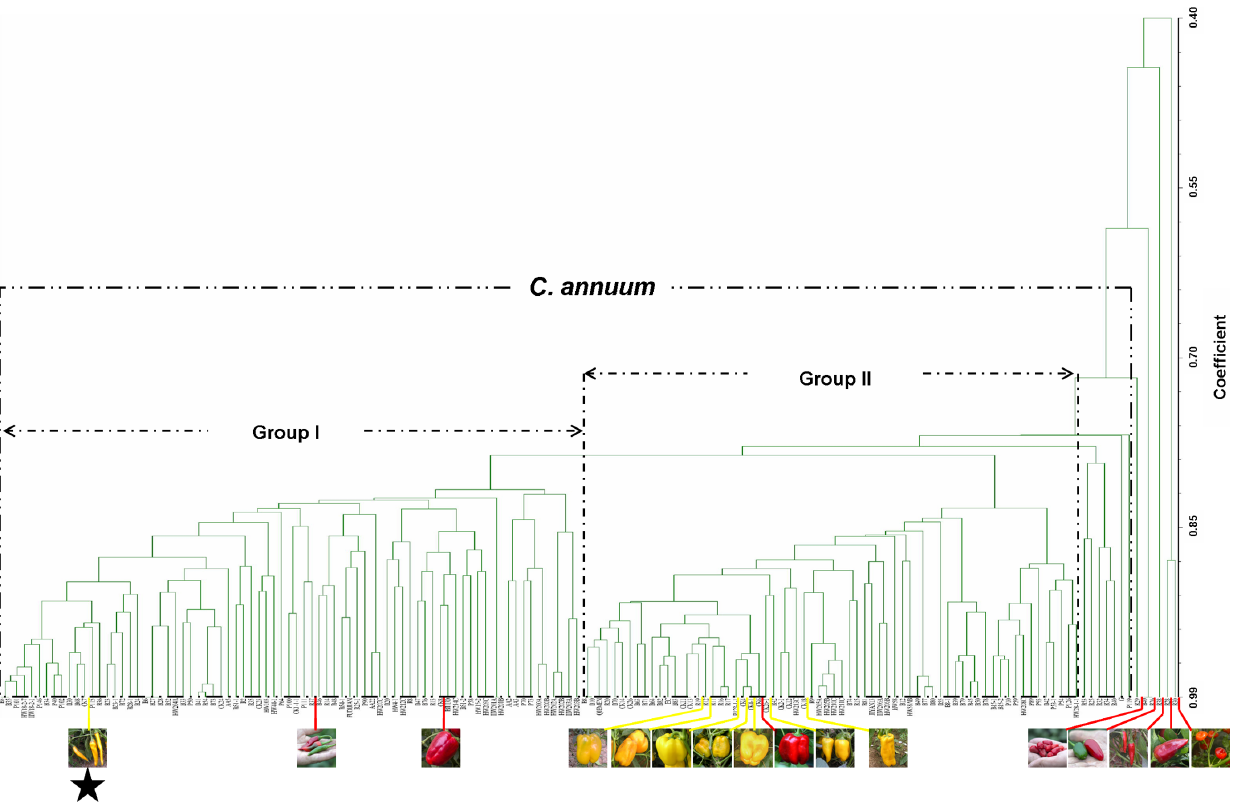
Figure 2. The clustering pattern obtained for all 156 pepper cultivars examined in this study using SSR analysis. The novel yellow ripe- color pepper line, CK7, is marked with an asterisk.